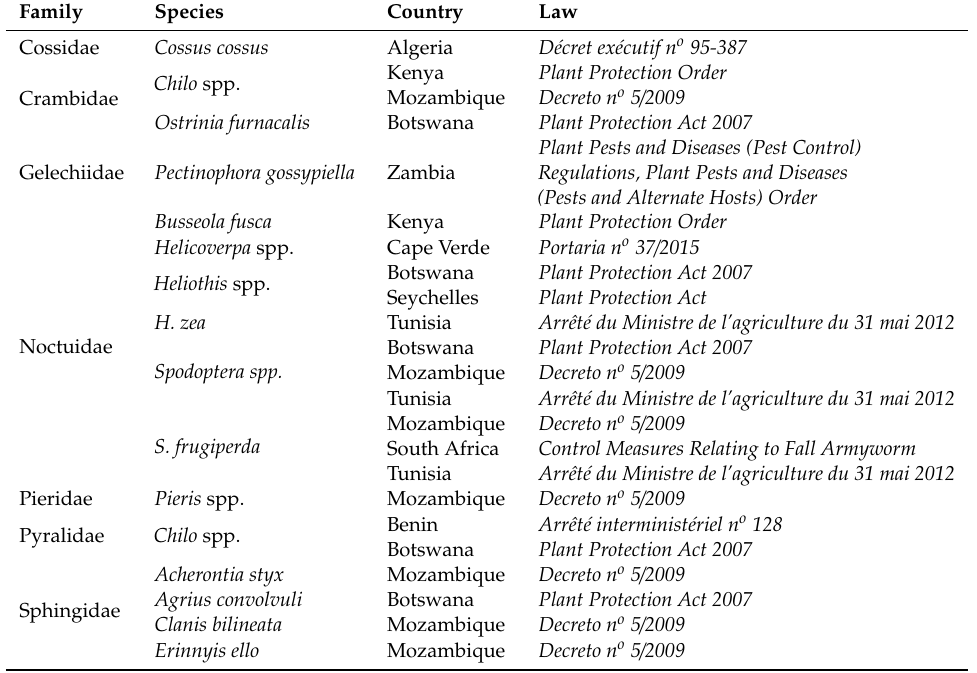
Table 8. Pest insect legislation pertaining edible insect species (as presented in [11]: butterflies and moths (Lepidoptera).